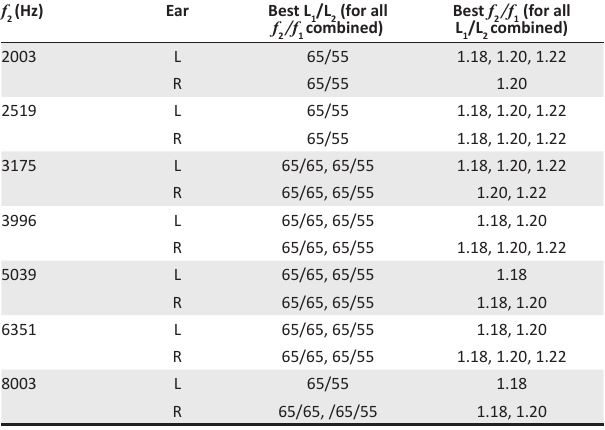
FIGURE 1 (Continues...): Mean distortion product otoacoustic emission absolute levels per intensity and frequency ratio combinations for each frequency ( f ear at 2003 Hz, (b) left ear at 2003 Hz, (c) right ear at 2519 Hz, (d) left ear at 2519 Hz, (e) right ear at 3175 Hz, (f) left ear at 3175 Hz, (g) right ear at 3996 Hz, (h) left ear at 3996 Hz, (i) right ear 5000 Hz, (j) left ear at 5000 Hz, (k) right ear at 6996 Hz, (l) left ear at 6996 Hz, (m) right ear at 8003Hz and (n) left ear at 8003Hz. Hz, hertz. TABLE 1: Results of the mixed model analyses for main effects ( p < 0.05) of level / f (L /L in dB SPL) and frequency ( f ) 1 2 2 1